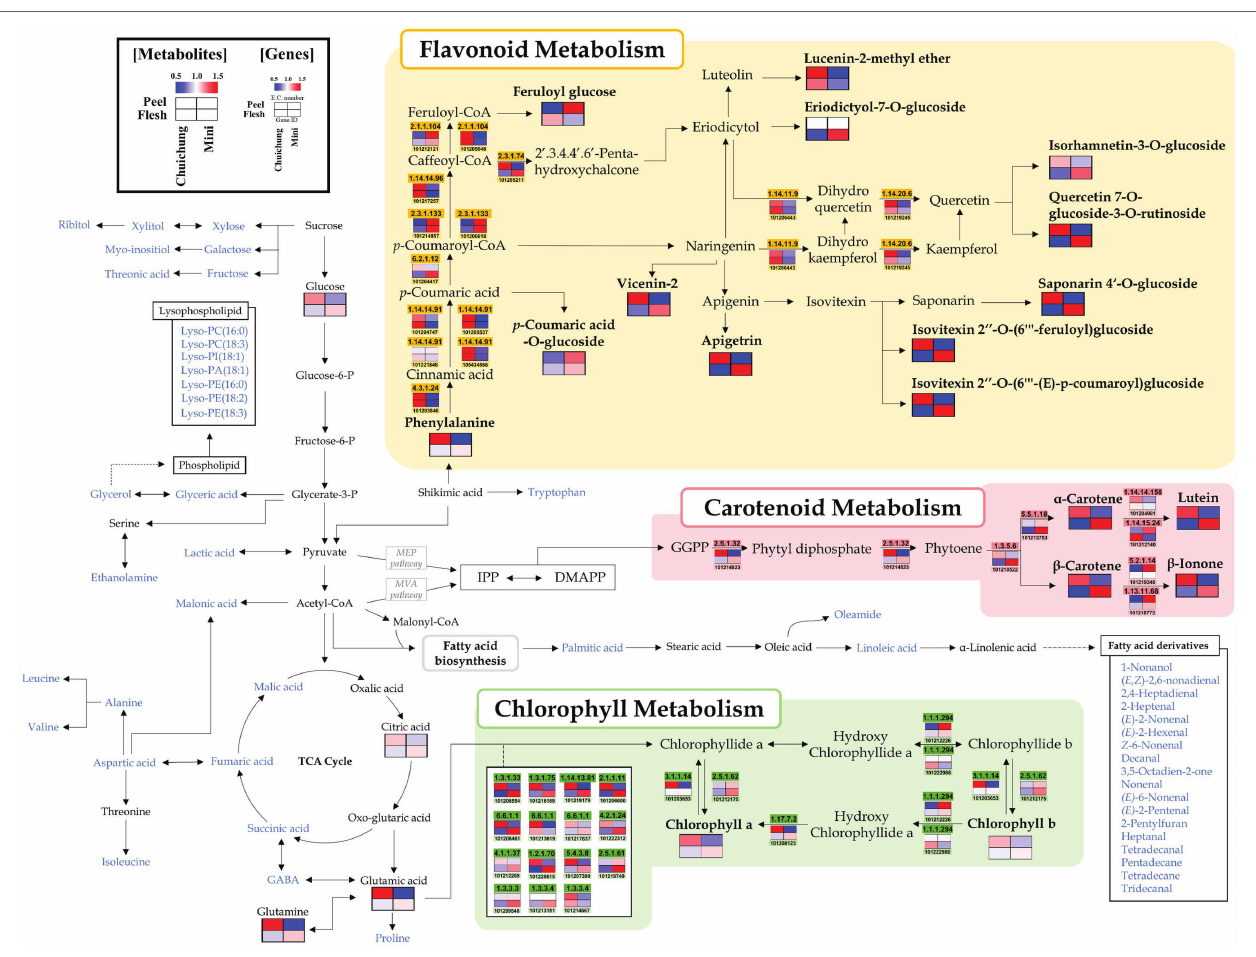
FIGURE 2 | Schematic representation of the flavonoid, carotenoid, and chlorophyll metabolic pathway with metabolite and related gene expression levels in the Chuichung and Mini cultivars. The pathway was modified from the Kyoto Encyclopedia of Genes and Genomes (KEGG) database (http://www.genome.jp/kegg/). The colored squares (blue-to-red) represent the relative abundance. The blue characters represent metabolites detected through the mass spectrometry, and the relative abundance of these metabolites is shown in Figures 4 , 5